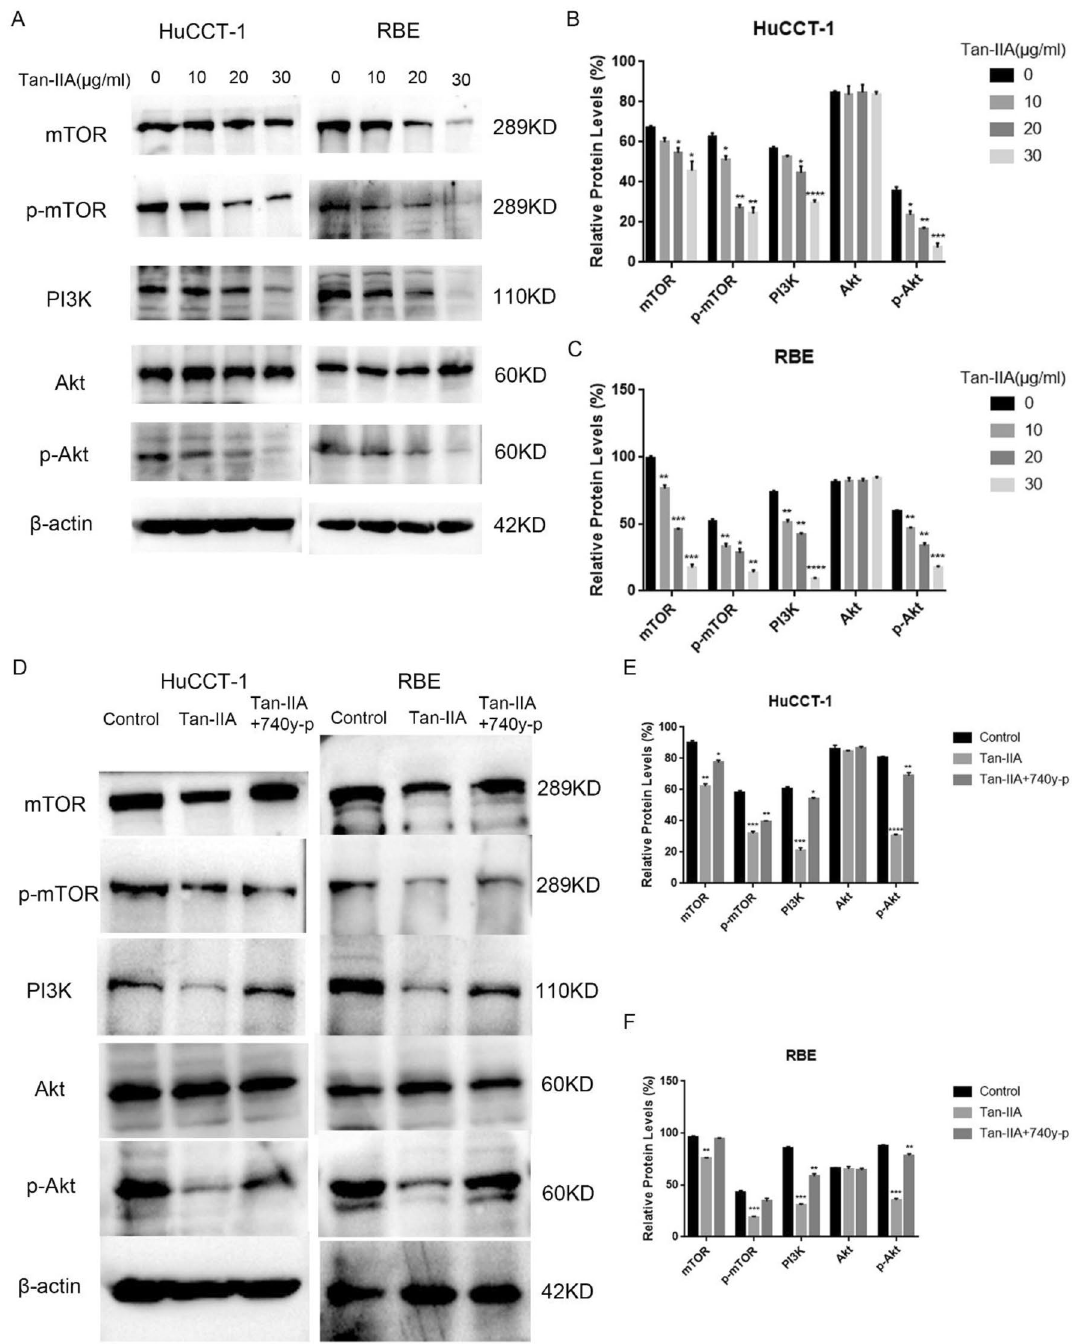
Figure 3. Tan-IIA can inhibit the PI3K-Akt-mTOR pathway. ( A – C ) Tan-IIA at concentrations of 0, 10, 20, and 30 µg/mL was added to fresh medium and co-cultured with Cholangiocarcinoma cells for 24 h. Next, the protein expression levels of PI3K, Akt, mTOR, p-Akt, and p-mTOR were measured using western blots. ( D – F ) After the addition of 740y-p (10 µg/mL) to the system in which Tan-IIA (24 h IC50 concentration) and Cholangiocarcinoma cells were co-cultured. The inhibitory effect of Tan-IIA on PI3K-Akt-mTOR pathway was diminished under the influence of PI3K agonists. Compared with control, * p < 0.05; ** p < 0.01; *** p < 0.001; **** p <